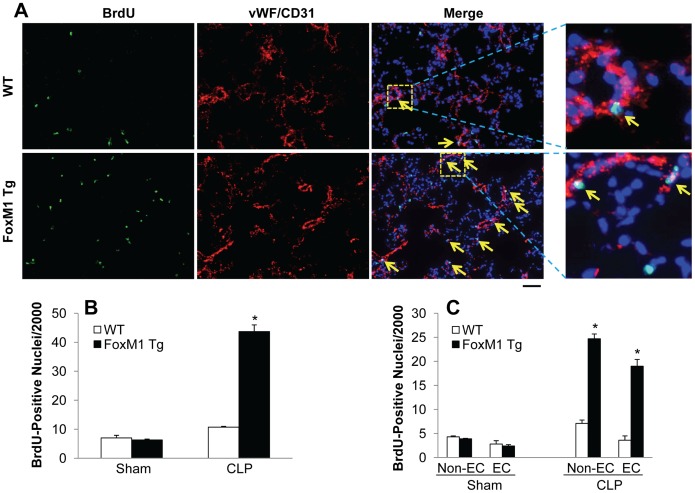
FoxM1-induced endothelial cell proliferation in FoxM1 Tg lungs following CLP challenge.(A) Representative micrographs of immunofluorescent staining. Lung tissues were collected at 24 h post-CLP challenge, sectioned and immunostained with anti-BrdU (green) and anti-vWF and CD31 (red) antibodies. Nuclei were counterstained with DAPI (blue). Arrows indicate proliferating EC. Scale bar, 50 µm. (B) Quantification of BrdU-positive nuclei. Data are expressed as mean ± SD (n = 4 per group). *, P<0.001 versus WT. (C) Quantification of BrdU-positive EC (vWF+ or CD31+) and non-EC (vWF- or CD31−). BrdU-positive EC were quantified in small vessels (diameter ≤ 100 µm) and capillaries. Data are expressed as mean ± SD (n = 4). P<0.001 versus WT.